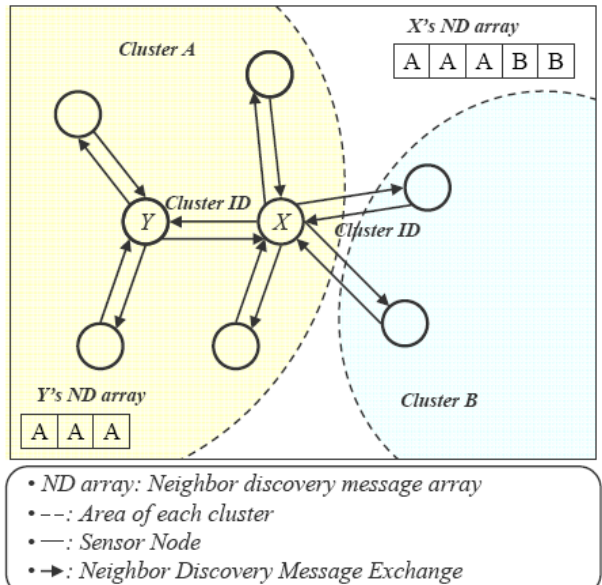
Figure 4. Node distinguish mechanism (decision about inter-cluster or intra-cluster